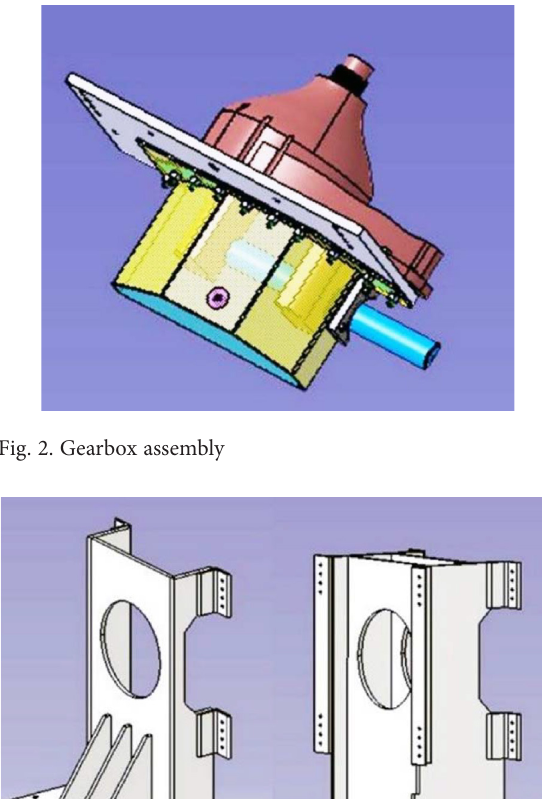
Fig. 1. The test rig with nominal speeds and torques